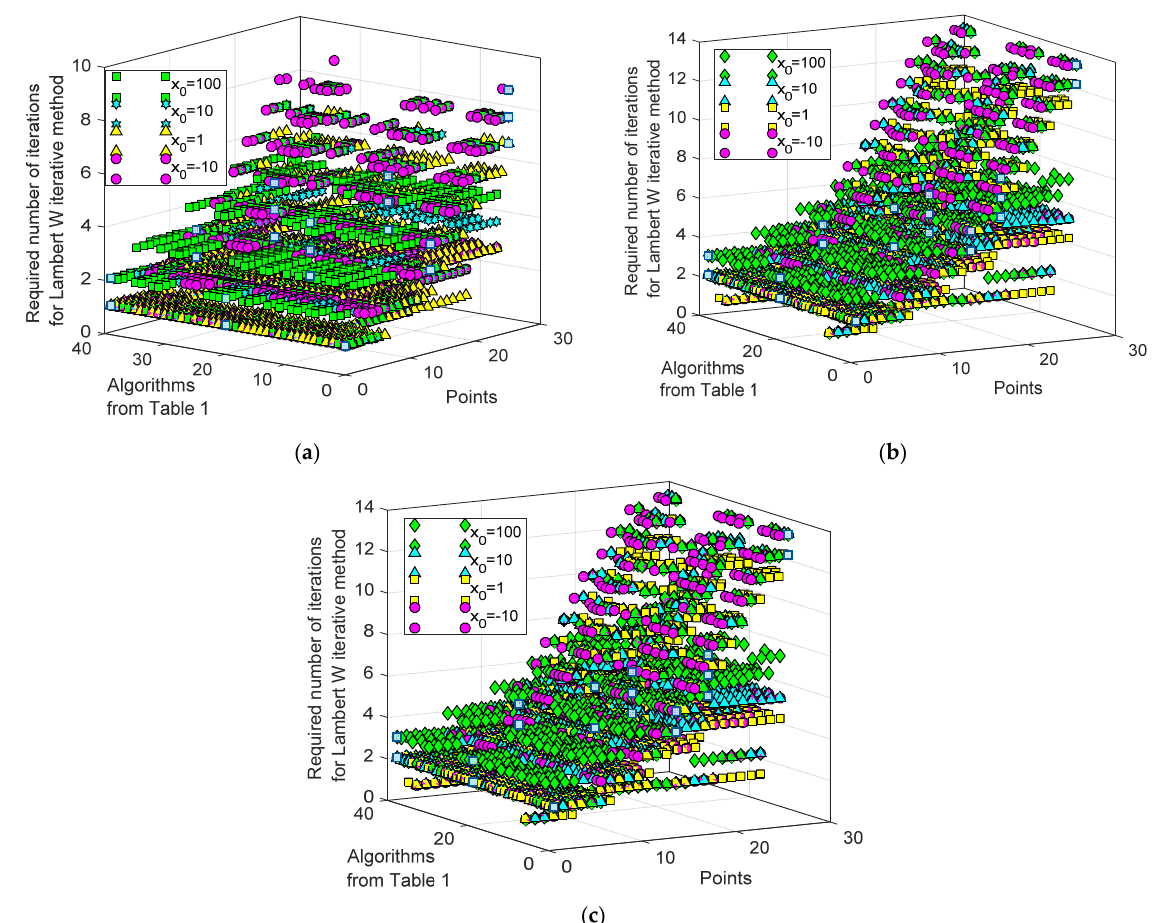
Figure 8. Required number of iterations for all voltage values with different stopping criteria using